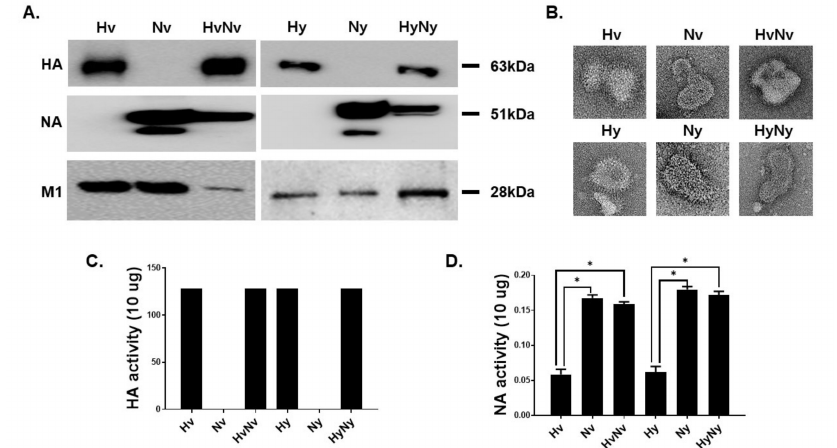
Figure 1. Characterization of the influenza B VLP vaccines. Western blots were performed and the expressions of HA, NA, and M1 proteins were confirmed using polyclonal and monoclonal antibodies ( A ). VLPs were negatively stained and visualized under the transmission electron mi- croscope ( B ). Chicken RBCs were used to assess the HA activity of the VLPs ( C ), and NA activity was evaluated using the Amplex Red assay kit ( D ). Data are expressed as mean ± SD with asterisks denoting statistical significance between groups (* p <